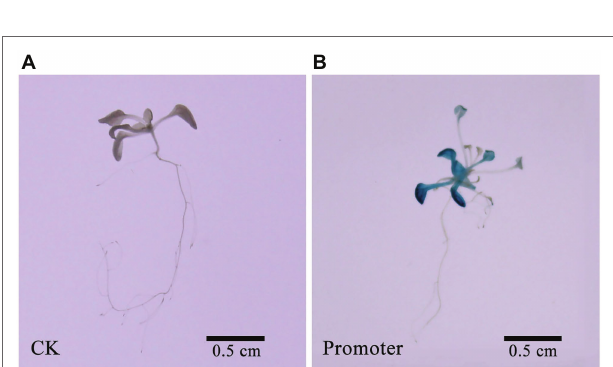
FIGURE 2 | GUS staining results of promoter. (A) CK. (B) Promoter.